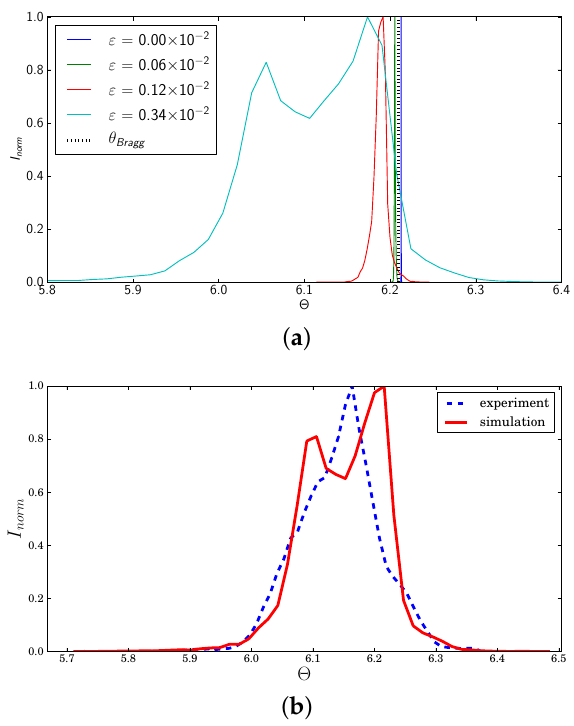
Figure 10. ( a ) Simulated rocking curves for Grain 4 at ω = 165 ◦ at four different strain levels; ( b ) comparison between experimental and simulated rocking curves at ε = 0.34